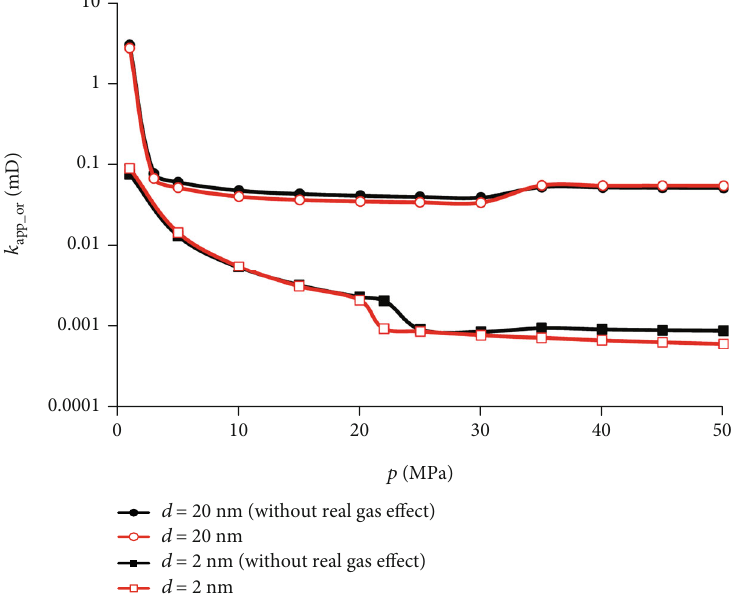
Figure 7: Organic pore AGP curves with and without considering the real gas e ff